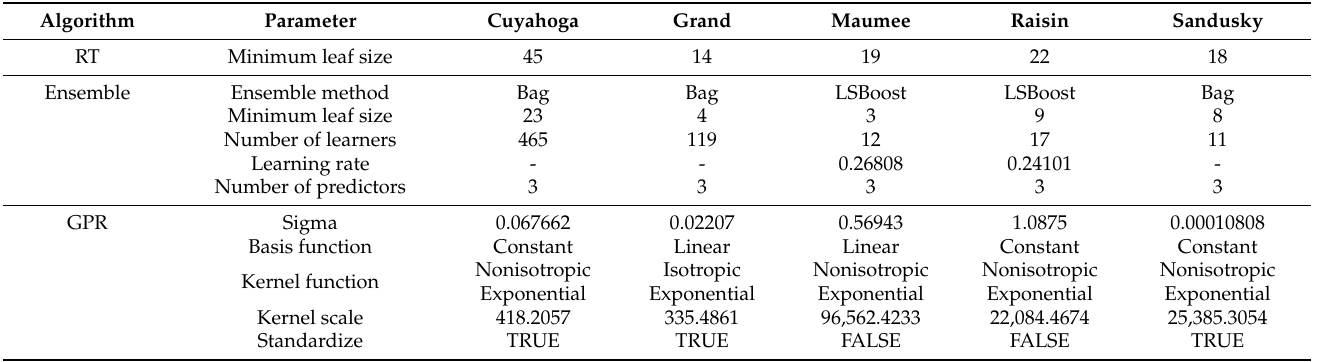
Table 5. Comparison of 𝑅 2 , RMSE, and MAE using different ML algorithms for phosphorus prediction on training da- taset.